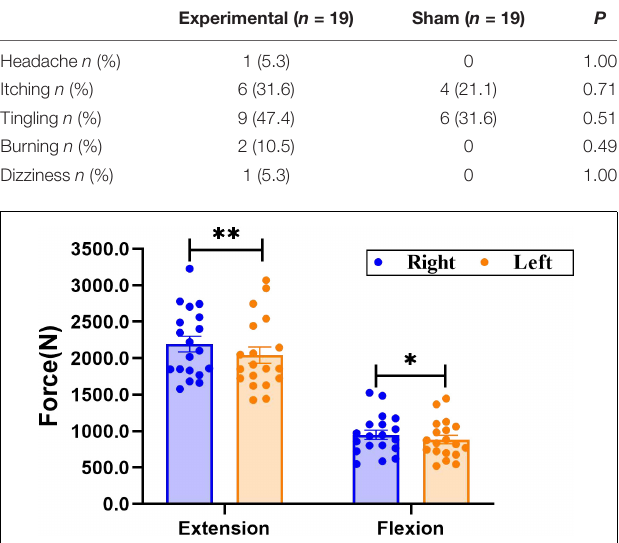
TABLE 1 | Comparison of adverse effects between experimental and sham tDCS.